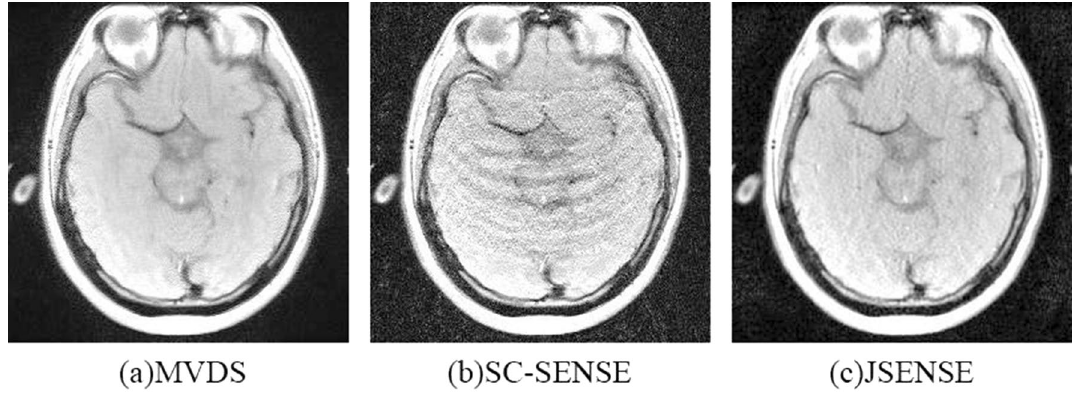
Figure 8. When R = 6 and ACS = 32, compare with other methods. ( a ) Proposed sampling method and the image reconstructed by NL-GRAPPA, kernel size is 15 × 2; ( b ) the SC-SENSE method; ( c ) the JSENSE method.